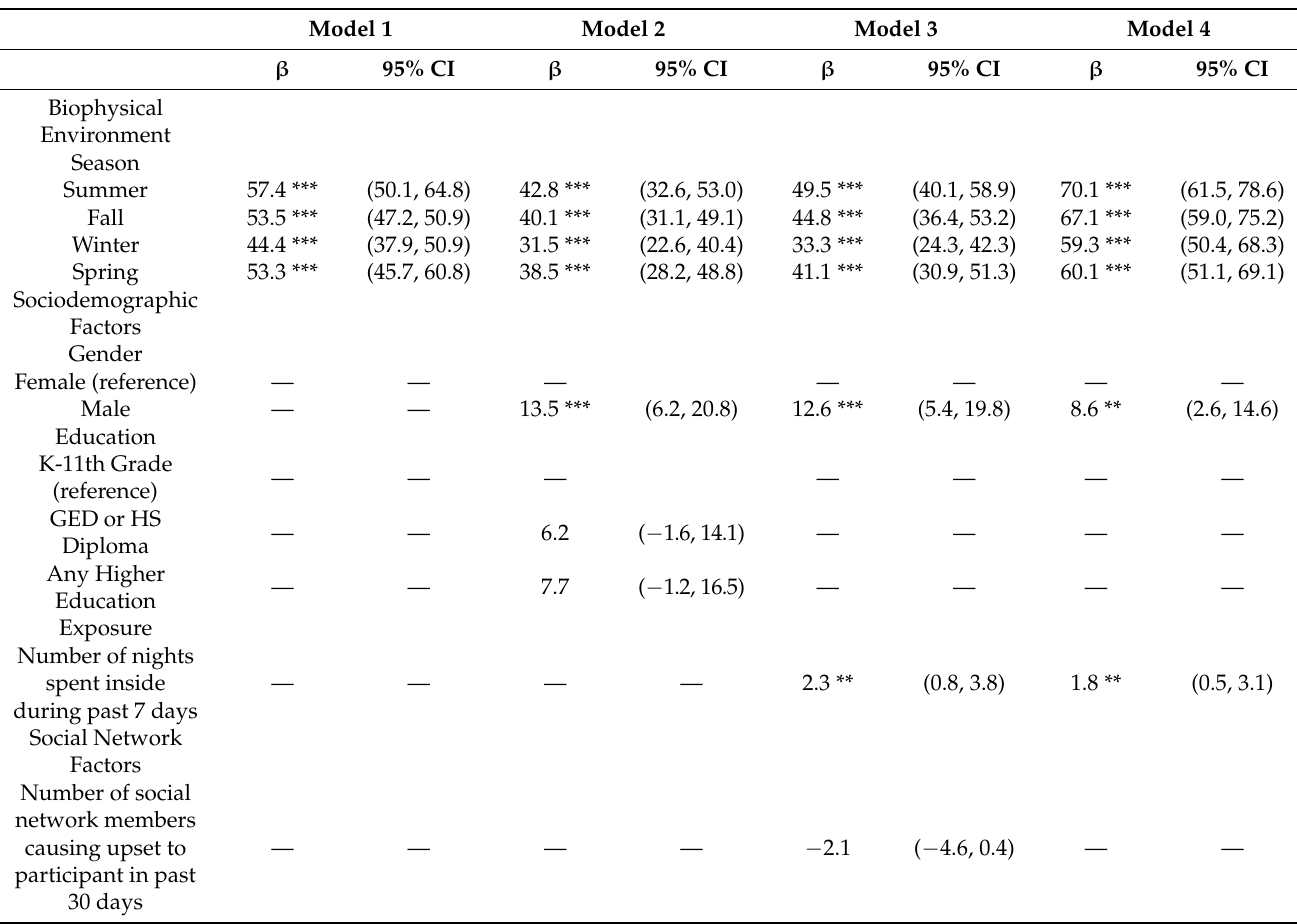
Table 7. Fixed-effects stepwise linear regression models exploring associations between seasonality, socio-demographic factors, environmental exposure, and chronic health conditions on general health scale score